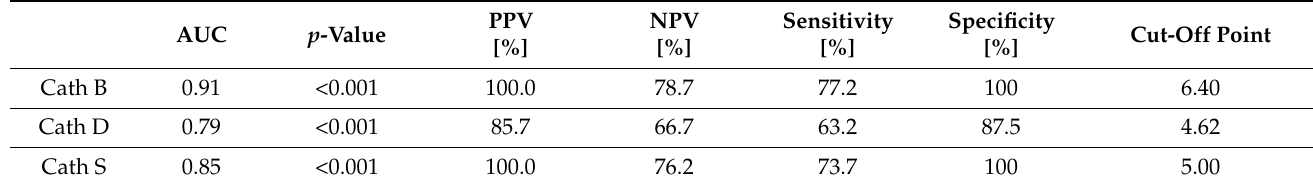
Figure 2. ROC curves as plasma diagnostic tests for ( A ) cathepsin B, ( B ) cathepsin D, ( C ) cathepsin S. Table 3. Diagnostic efficacy of cathepsin B, D and S in